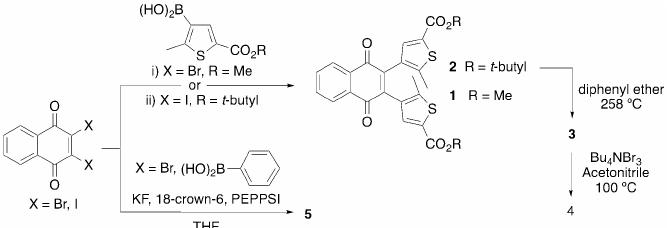
Figure 2. Structures of 4-naphthoquinone diarylethenes (nqDAEs) 1 – 4 in the open and closed forms as well as the structure of phenyl nqDAE 5 .